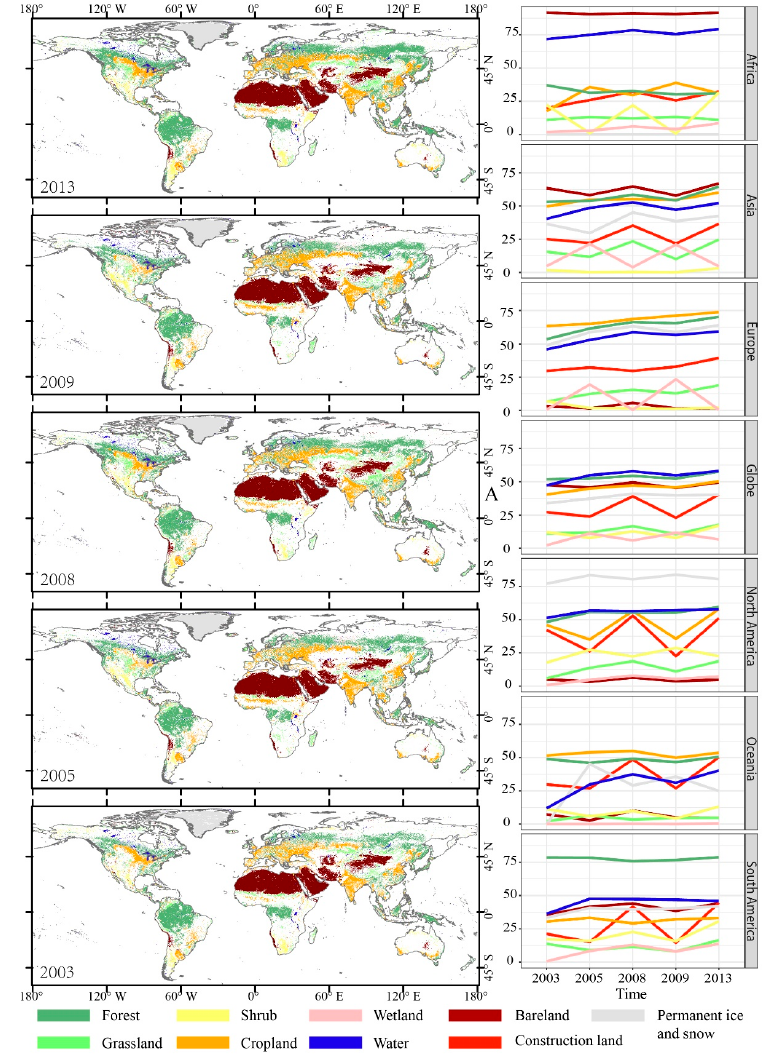
Figure 3. Spatial multiple-consistency at the global and continental scales. The left figure presents the high consistency of the global spatial distribution, and the right figure presents the inter-annual variations in the spatial multiple-consistency of each land use type at the continent and global scales.